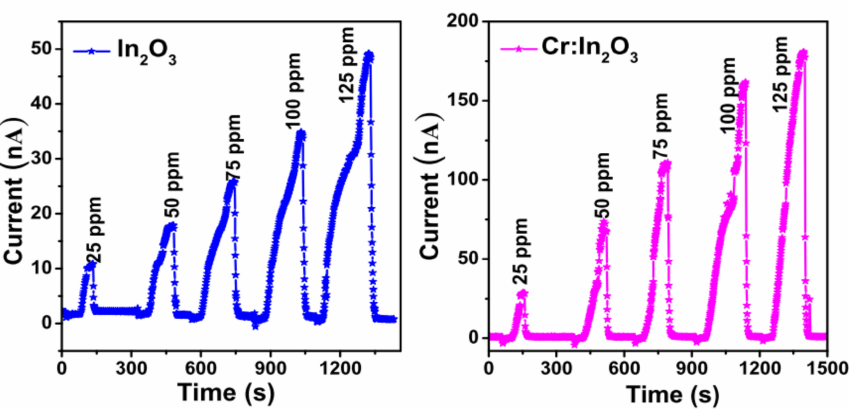
Figure 7. Electrical current variation of pure In 2 O 3 and Cr doped In 2 O 3 thin films at different NH 3 concentration